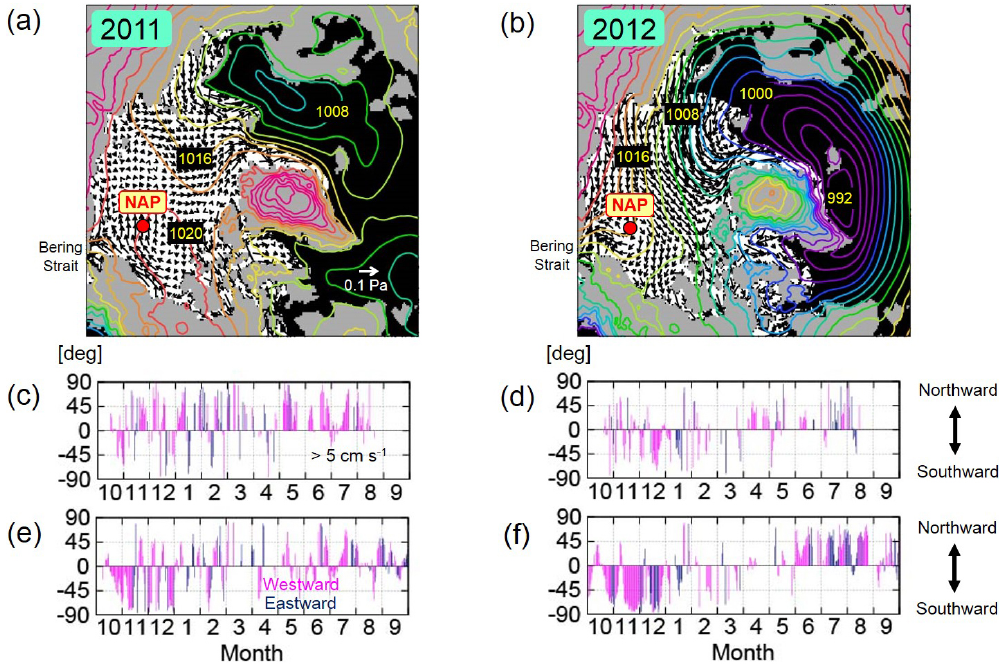
Figure 10. (a–b) (contours) Sea level pressure (SLP) (hPa) and (vectors) wind stress averaged (a) from November 2010 to January 2011 and (b) from November 2011 to January 2012. SLP is obtained from the NCEP/CFSR data set, and wind stress vectors are calculated from the SLP field using the AOMIP formulation. Unit vector of wind stress is 0.1Pa. Direction of (c–d) satellite-based and (e–f) modeled sea ice velocity in the NAP region (degree). Only daily averages whose velocity exceeded 5cms − 1 in the (c, e) 2011 and (d, f) 2012 periods are plotted. Positive (negative) values of the direction correspond to northward (southward), and magenta (navy) bars indicate westward (eastward) motions, respectively. For example, a magenta bar of − 45 ◦ means southwestward direction of 225 ◦ T, where 0 ◦ T corresponds to true